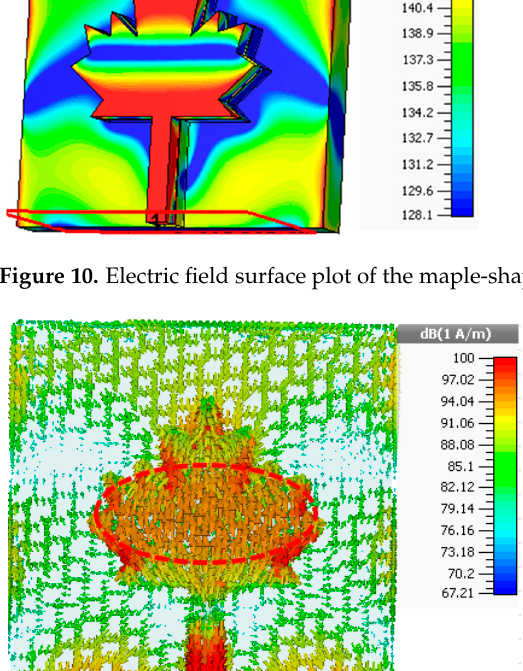
Figure 11. Surface current plot for the maple shape.